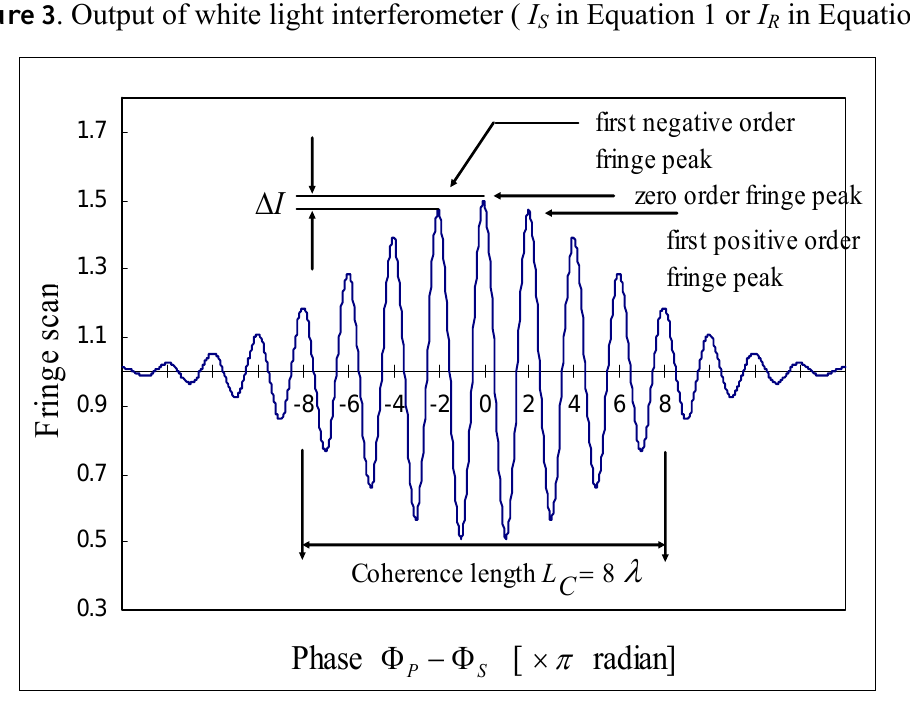
Figure 3 . Output of white light interferometer ( I